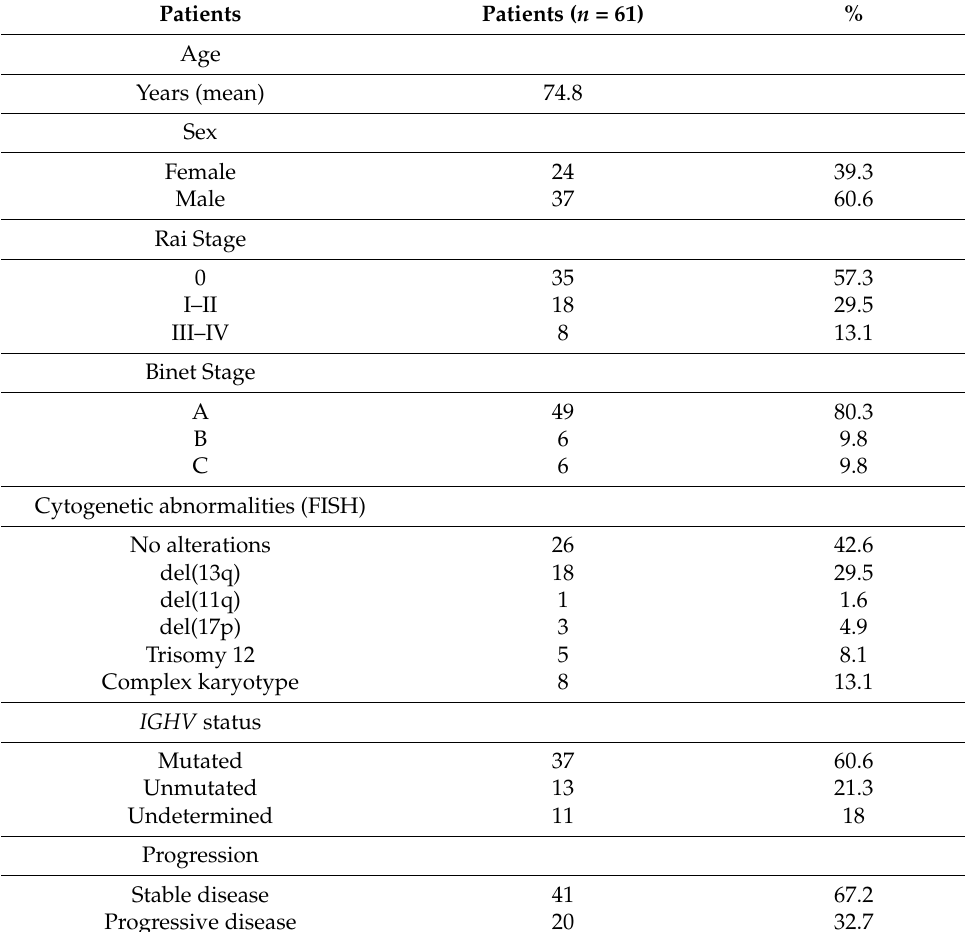
Table 1. Clinical characteristics of patients with CLL included in the